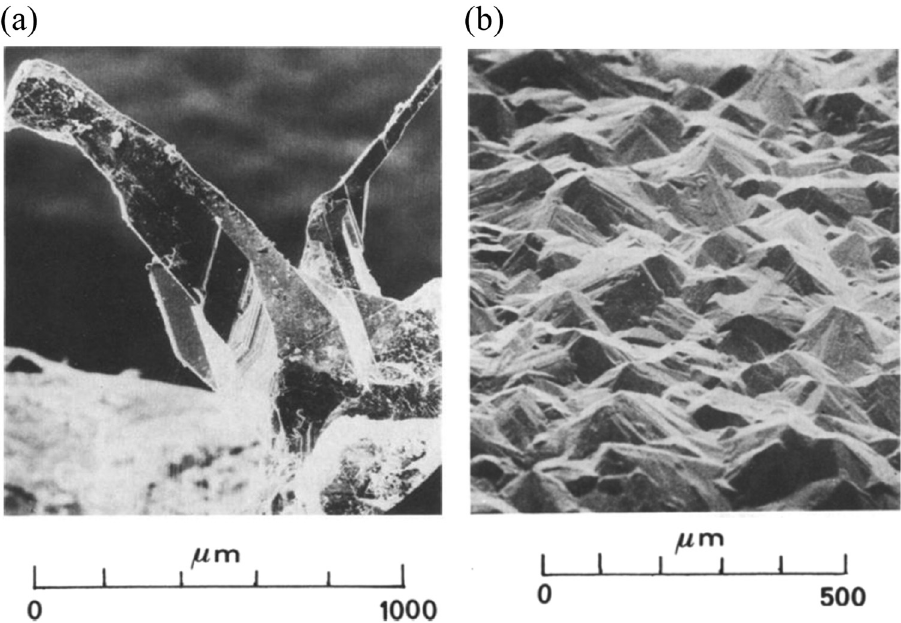
Figure 5: SEM images of electrodeposited Si prepared in molten LiF – NaF – KF containing 5 mol% Na 2 SiF 6 at 1,023 K. ( a ) Constant current electrolysis at – 20 mA · cm − 2 . ( b ) Pulsed current electrolysis at – 40 mA · cm − 2 for 30 s, + 40 mA · cm − 2 for 1 s, and 0 mA · cm − 2 for 60 s [ 104 ] . Permission from